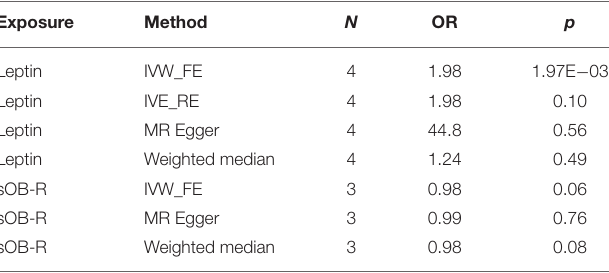
TABLE 2 | Two-sample MR estimates of relationship between genetically predicted circulating leptin/sOB-R levels and SCZ.